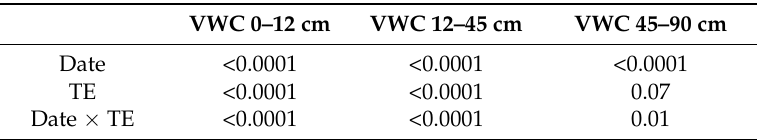
Table 1. Statistical significance for the effects of date and throughfall exclusion (TE) on volumetric soil water content (VWC) from 0–12 cm, 12–45 cm, and 45–90 cm for the entire measurement period (2013–2014).